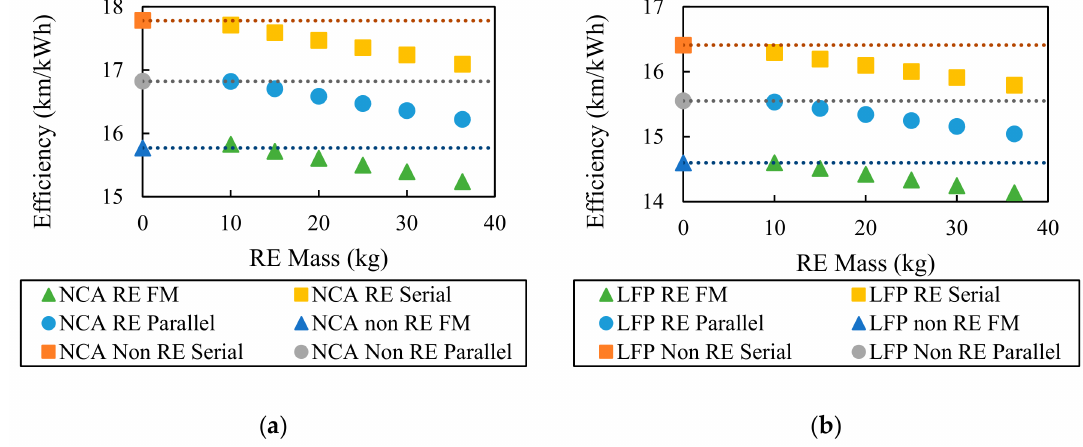
Figure 17. E ffi ciency vs. mass of the vehicle with various RE mass in ( a ) NCA and ( b ) LFP